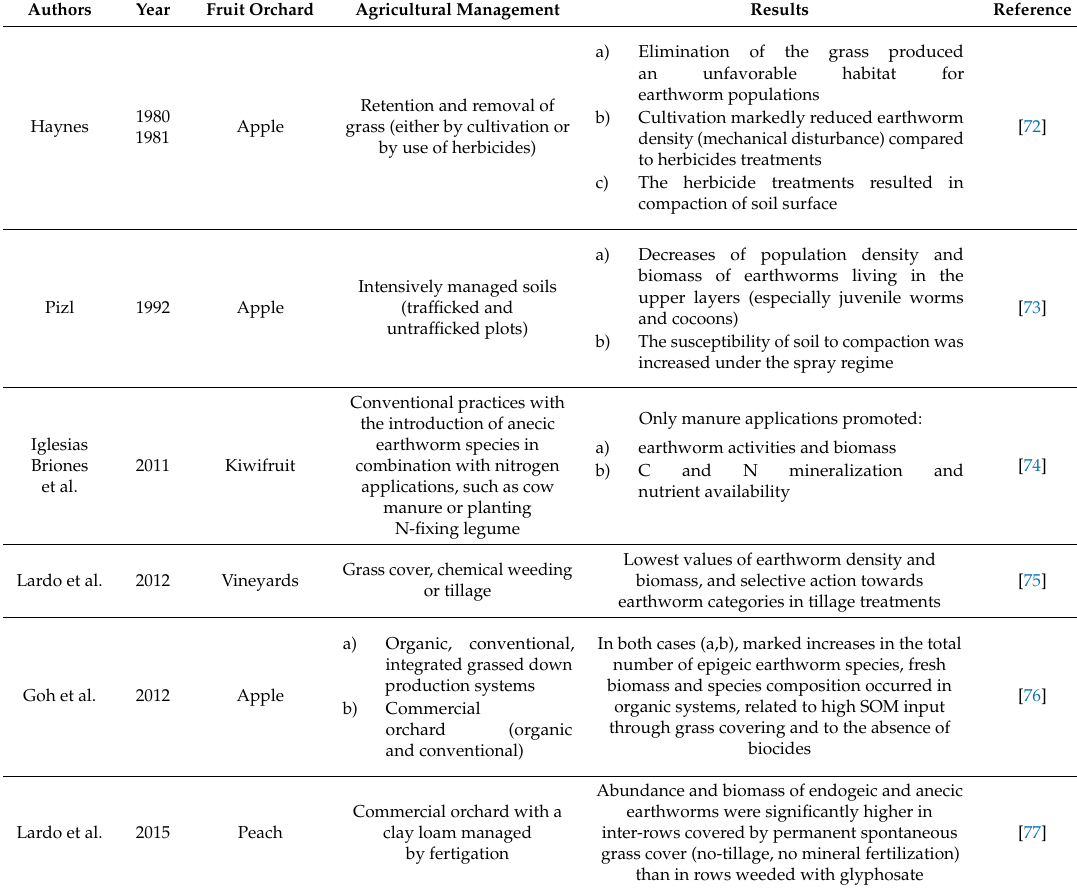
Table 1. E ff ects of di ff erential agricultural management on earthworm dynamics in orchard